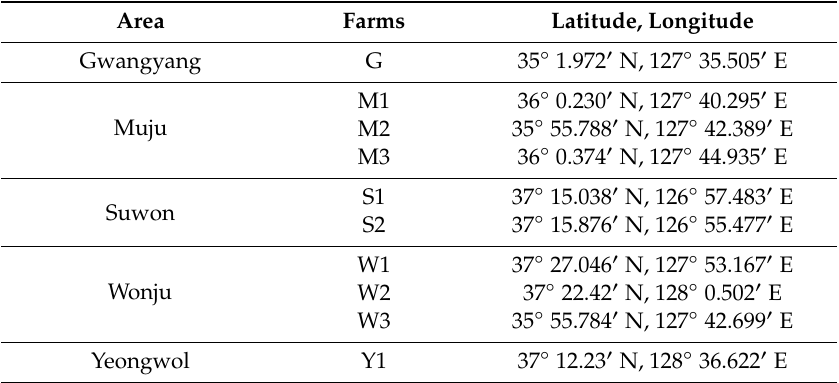
Table 1. Location of each farm of five areas.